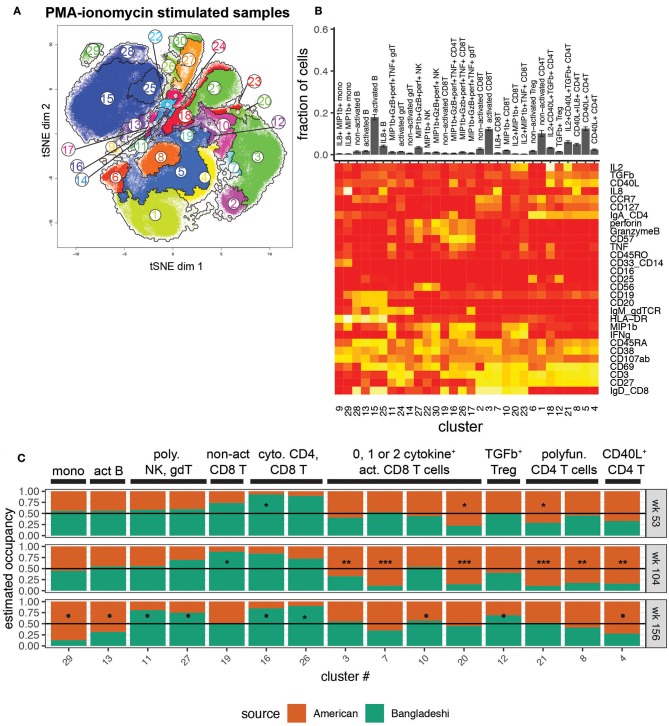
Location-based differences in functional responses to stimulation. Markers used for the tSNE and clustering processes were selected based on relevance to cell phenotypes and functional characterization. Samples include 24 from American children (week 53 n = 5, week 104 n = 11, week 156 n = 8), 34 from Bangladeshi children (week 53 n = 19, week 104 n = 9, week 156 n = 6), and 30,000 randomly sampled cells from 3 American adults. (A) tSNE map with overlaid AdjClust clusters on aggregate of all samples included in the analysis. Using AdjClust, 30 unique clusters were identified that delineated cell differentiation and function/activation. Minimum cluster size was set to 1,500 cells. (B) Cell phenotypes and functions identified with AdjClust on PMA-ionomycin stimulated samples. Labels were manually assigned based on marker expression. The fraction of cells in each cluster represents aggregate data from Bangladeshi and American children's stimulated samples. (C) Ratio of cluster occupancy between age-matched Bangladeshi vs. American children. Only clusters with FDR < 0.01 are shown. For each time point, Mann-Whitney tests were performed for each of the 28 clusters. p-values were then corrected for multiple testing using the Benjamini and Hochberg method. Significance levels of the cluster occupancy differences between Bangladeshi and American children are indicated by FDR < 0.1 (•), FDR < 0.05 (*), FDR < 0.01 (**), FDR < 0.001(***).